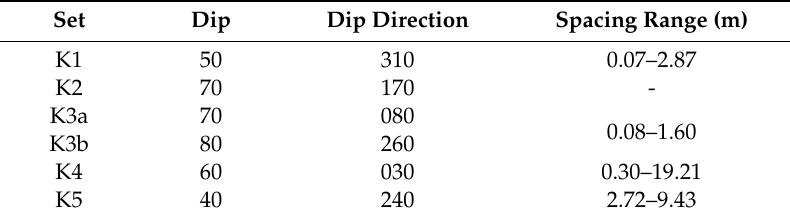
Table 4. Average orientation and spacing of the main discontinuity sets obtained from non-contact surveys.